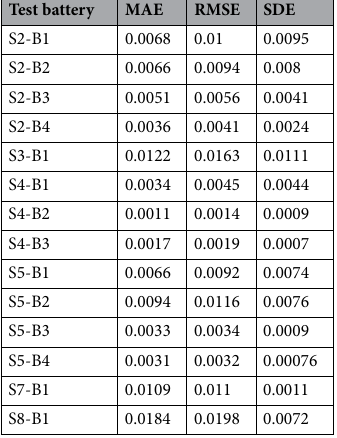
Table 2. SOH estimation results for on-device test.